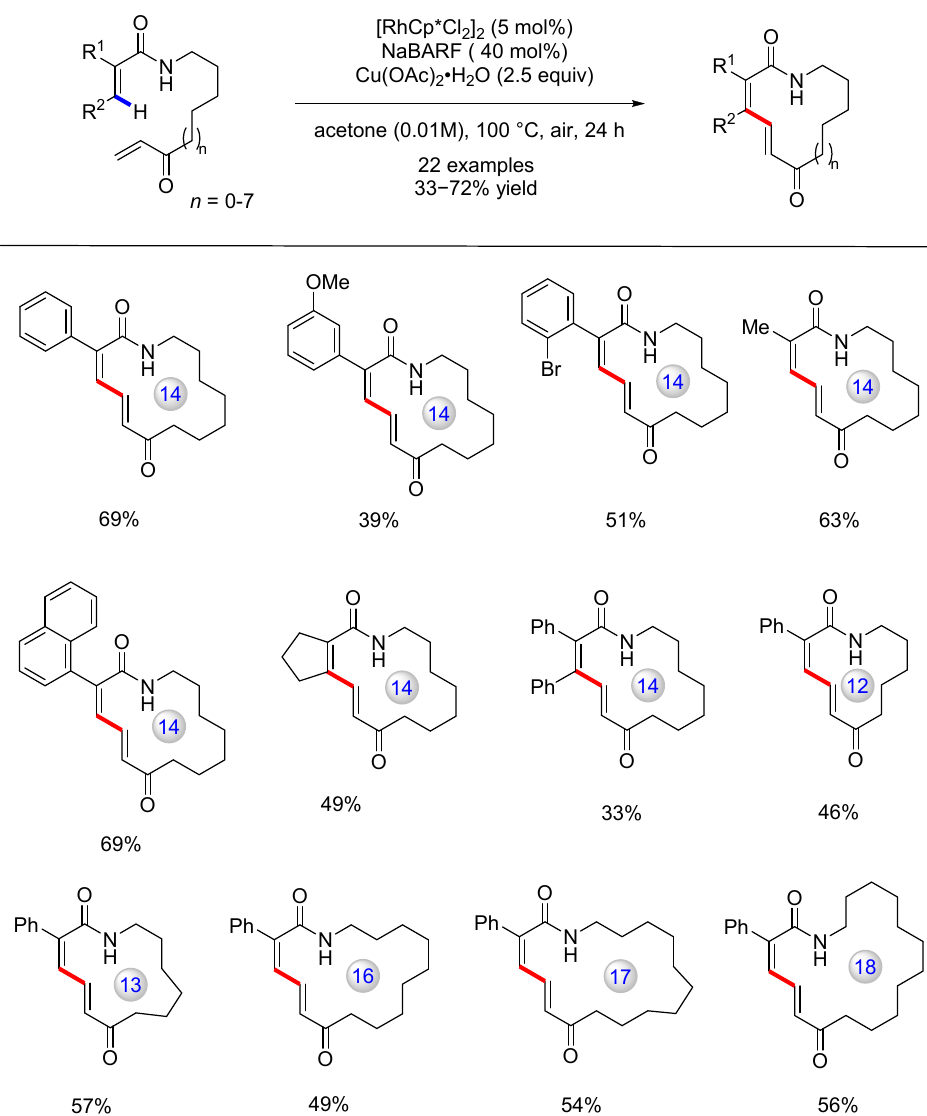
Figure 6. Macrolactam synthesis via Cp*Rh(III) ‐ catalyzed intramolecular ring ‐ closing alkene − alkene cross ‐ couplings [57].